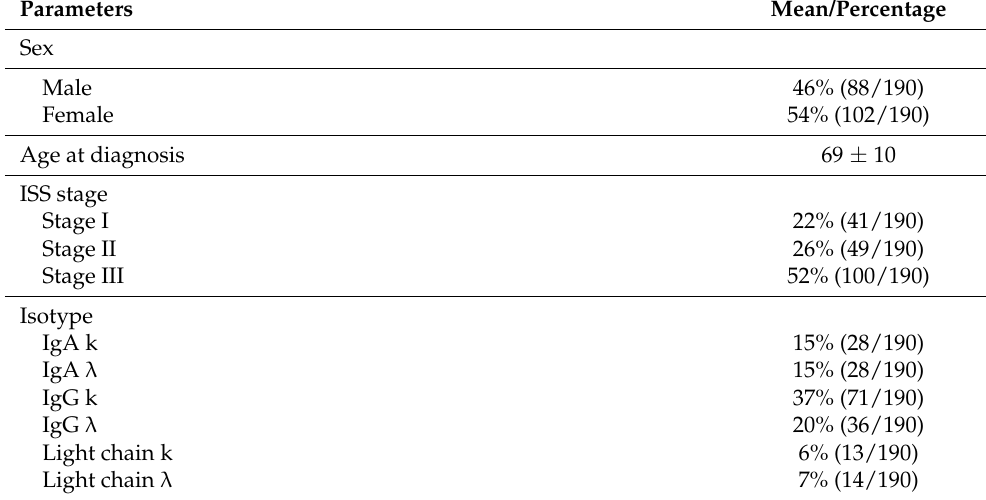
Table 1. Characteristics of the